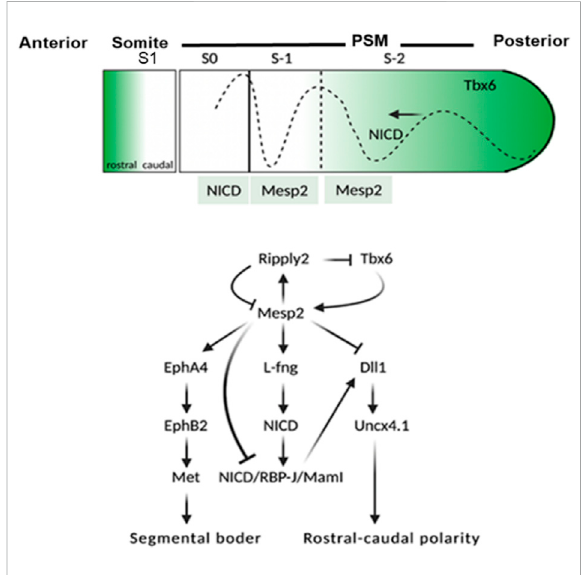
FIGURE 1 Schematic representation of events involved in the activation of MESP2 . TBX6 along with Notch1 signaling leads to the expression of MESP2 in the anterior presomitic mesoderm (NICD dotted line). The dotted line toward the anterior along with the black arrow shows the Notch1 signal wavers in the presomitic mesoderm. As MESP2 protein is formed within S1, NICD is suppressed indirectly via activation of LFNG , and directly via inhibition of DLL1 . The expression of MESP2 protein inhibits the expression of DLL1 and Uncx4.1 caudal genes; however, it induces the expression of rostral genes EphA4, EphB2, and followed by mesenchymal-to-epithelial transition (MET) within somites leading to segmentation of the rostral-caudal polarity within the somites is generated via a RIPPLY2 – MESP2 negative feedback loop. S1 = formed somite; S0 = somite under formation; S1 and S2 = somite